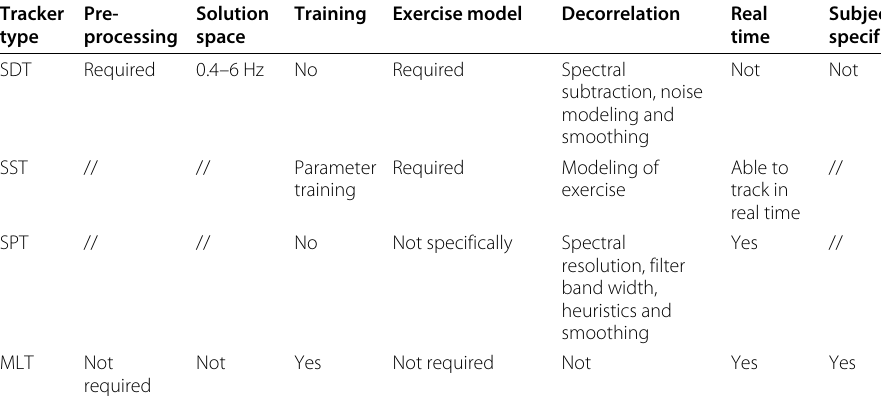
Table 3 General properties of different HR tracking techniques Tracker